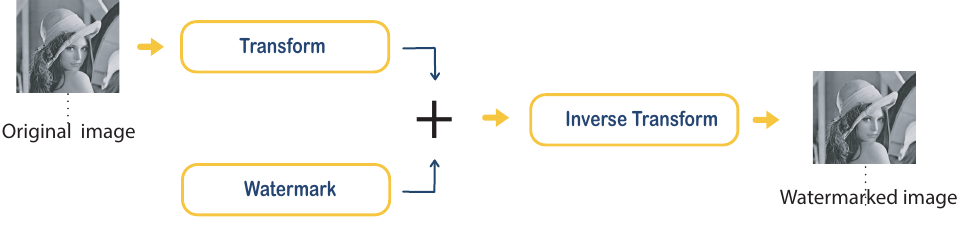
Figure 5. Embedding by additive